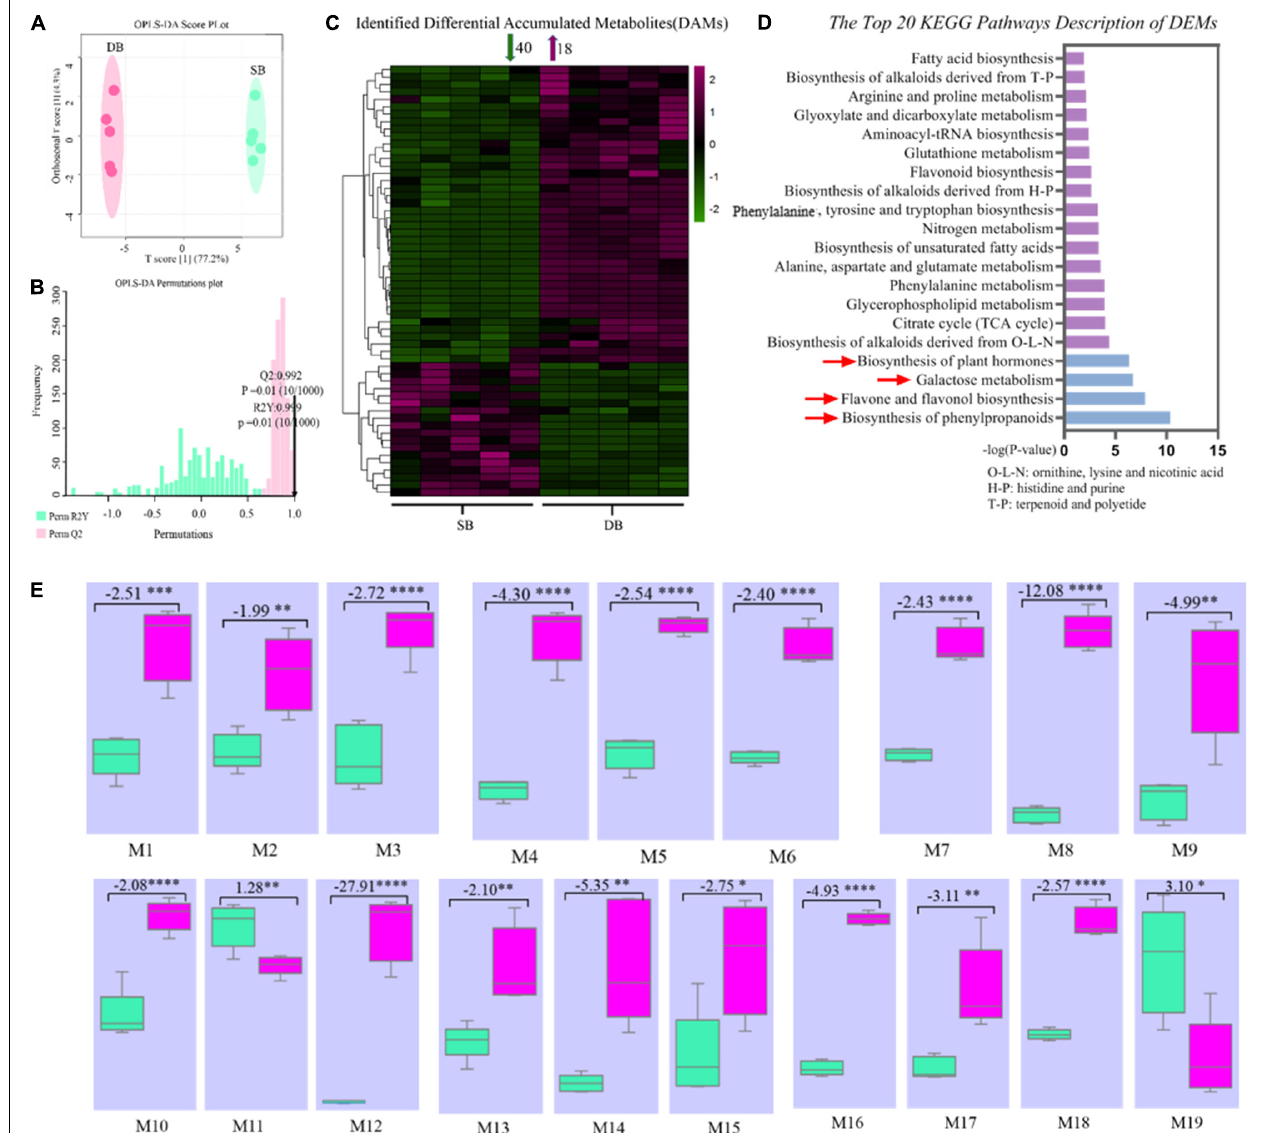
FIGURE 4 | (A) OPLS-DA (Orthogonal partial least squares discriminant analysis) score plot of metabolites. (B) OPLS-DA permutation plot of metabolites. (C) Heat map of identified differentially expressed metabolites. (D) KEGG pathway enrichment analysis of metabolites in the SB and DB tissues. (E) Box plots of key metabolites in the top four KEGG pathways. (M1-19) Box plots of peak areas of metabolites in the SB and DB tissues. Box plot data represent fold change of metabolites in the SB and DB tissues, with positive values indicating up-regulation and negative values denoting down-regulation. Asterisks indicate the level of significant difference. In panel (E) , M1: (-)-epicatechin; M2: 4-hydroxycinnamic acid; M3: alpha-linolenic acid; M4: APIIN; M5: citrate; M6: D-mannose; M7: galactinol; M8: kaempferol; M9: L-arginine; M10: L-glutamate; M11: L-malic acid; M12: quercetin; M13: raffinose; M14: rutin; M15: salicylic acid; M16: shikimate; M17: sinapyl alcohol; M18: sucrose; M19: coniferol. Detailed annotation information on differentially expressed metabolites (DEMs) was shown in Supplementary Table 2 . Detailed annotation information on key DEMs was shown in Supplementary Table 3